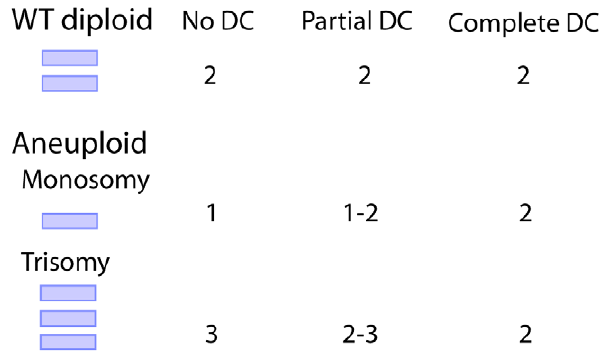
Figure 1. Expression levels change in response to altered gene dose in aneuploidy. The transcript output from a given pair of chromosomes in normal WT diploid cells is set as a value of 2. In case of aneuploidy (monosomy or trisomy), the amount of transcript would be strictly correlated with gene dose in the absence of a dosage compensation mechanism (No DC). In the presence of partial DC, the expression level per copy would be partially increased in monosomy or partially decreased in trisomy, relative to the diploid level. In the presence of complete DC, expression levels would be adjusted so that the amount of transcripts is the same in monosomic or trisomic cells compared to diploid cells.